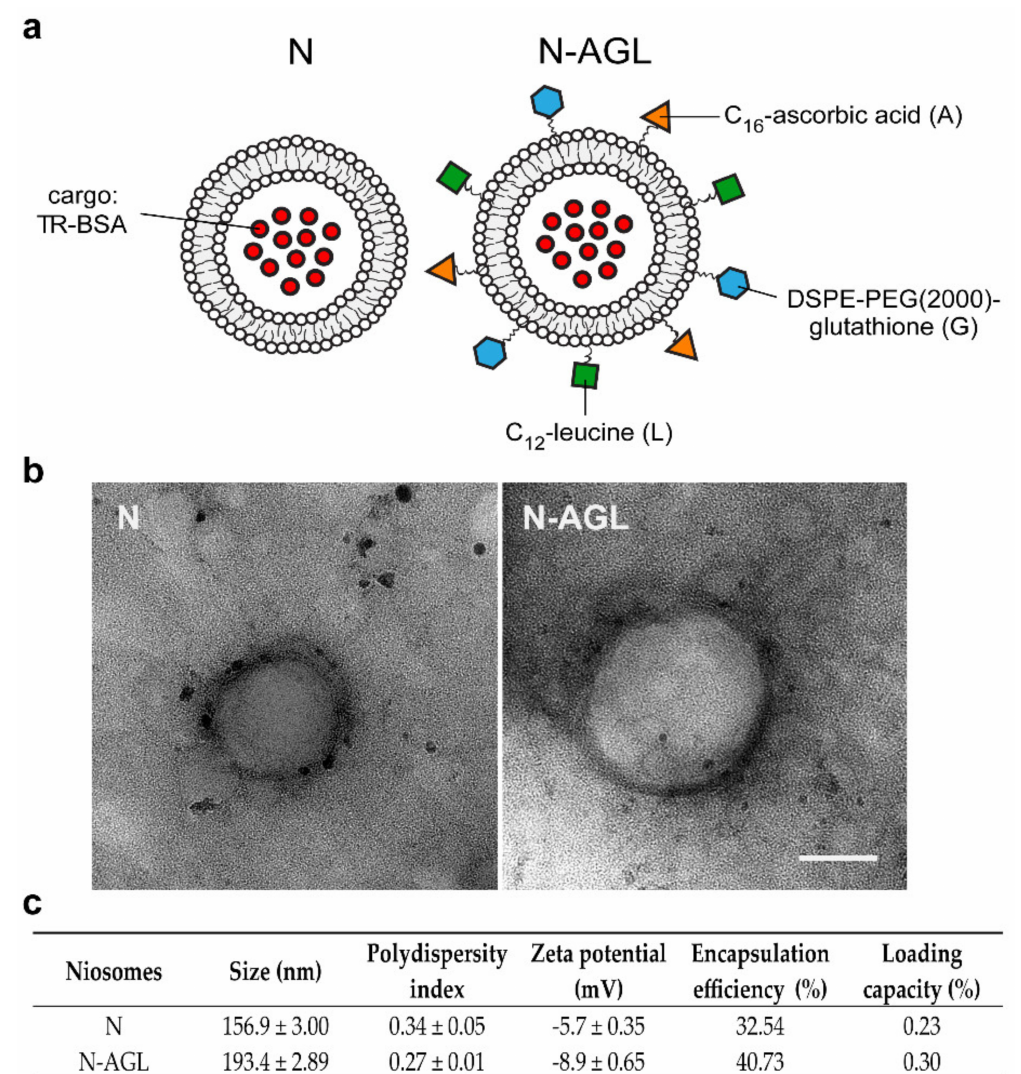
Figure 1. ( a ) Schematic drawing of non-targeted (N) and ascorbic acid-glutathione-leucine targeted (N-AGL) nanoparticles. TR-BSA: Texas red-labeled bovine serum albumin. ( b ) TEM images of nanoparticles. Bar: 100 nm. ( c ) Main physico-chemical properties of the nanoparticles. Values presented are means ±